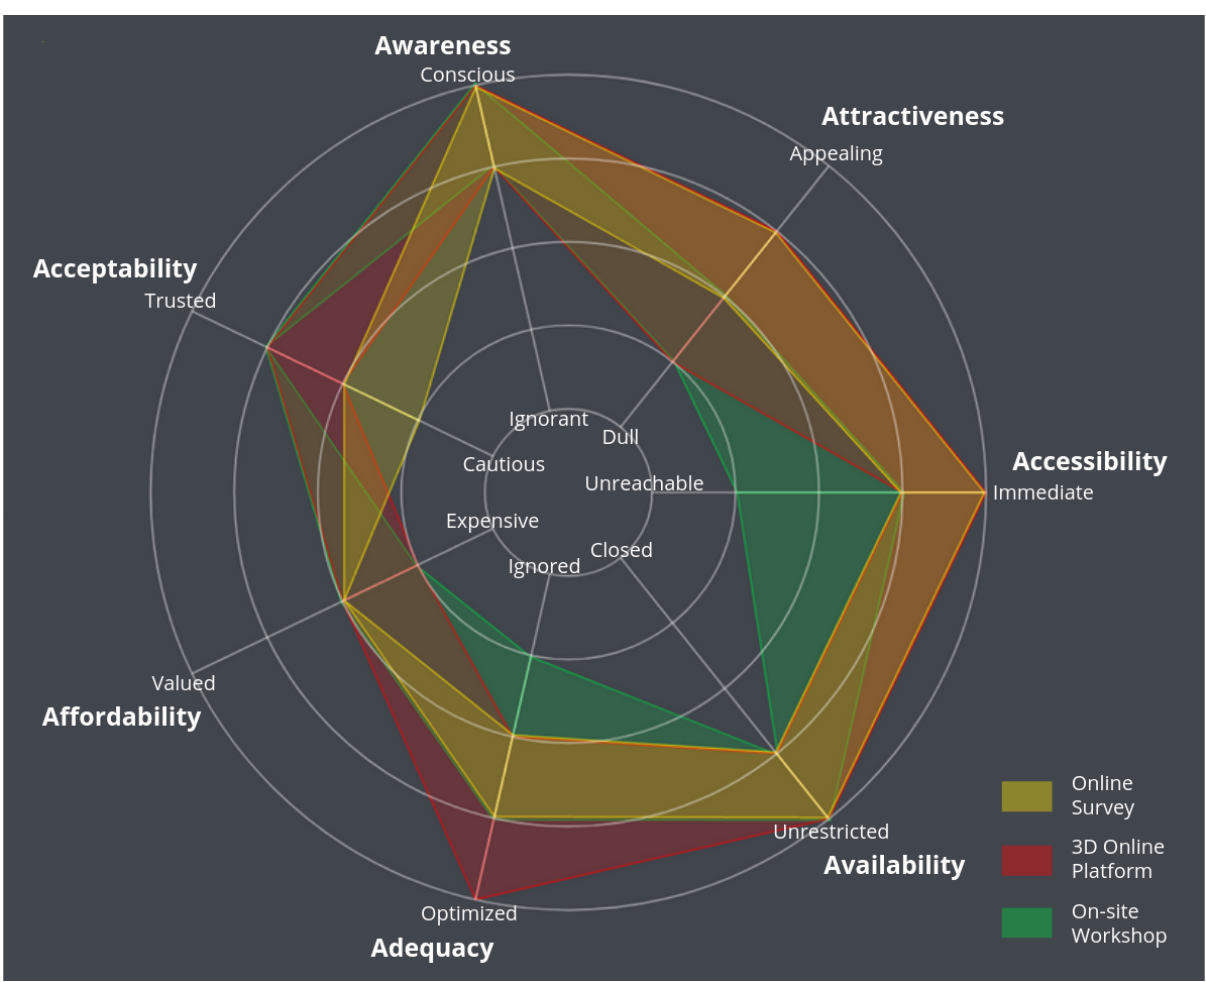
Figure 3. Dimensions estimation for the three alternatives studied for this urban planning